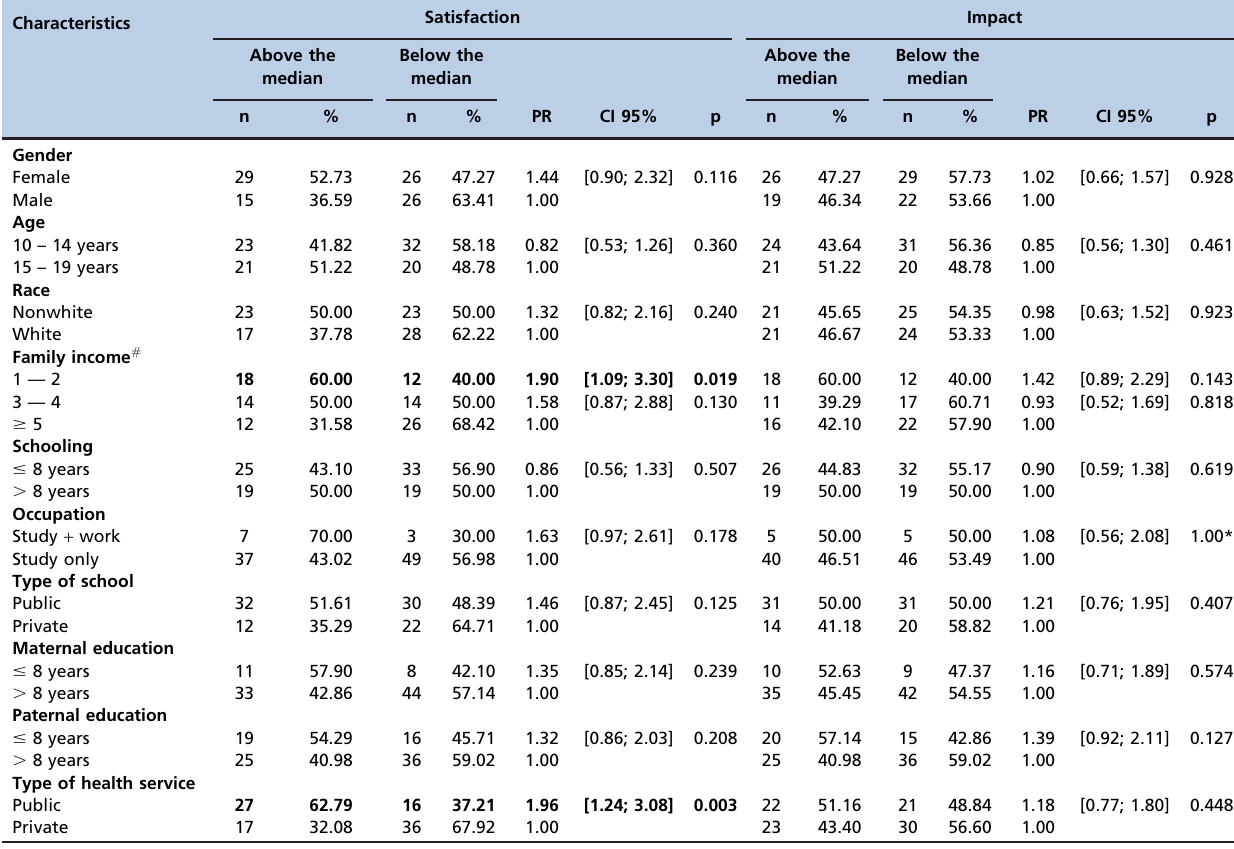
Table 2A - Bivariate analysis of associations between sociodemographic characteristics and the domains ‘‘Satisfaction’’ and